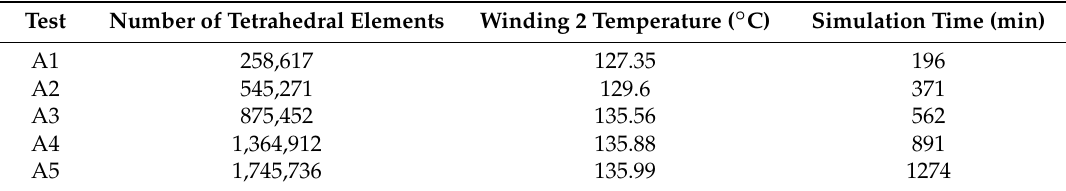
Figure 3. ( a ) Detail of the cooper winding and iron silicon contact and ( b ) tetrahedral mesh. The mesh size was chosen from a mesh refinement test. Table 1 presents the test refinement results. The average temperature on winding 2 was chosen as refinement parameter. As presented, due to the increase of simulation time, the mesh with 1,745,736 tetrahedral elements was chosen. Table 1. Mesh refinement test.